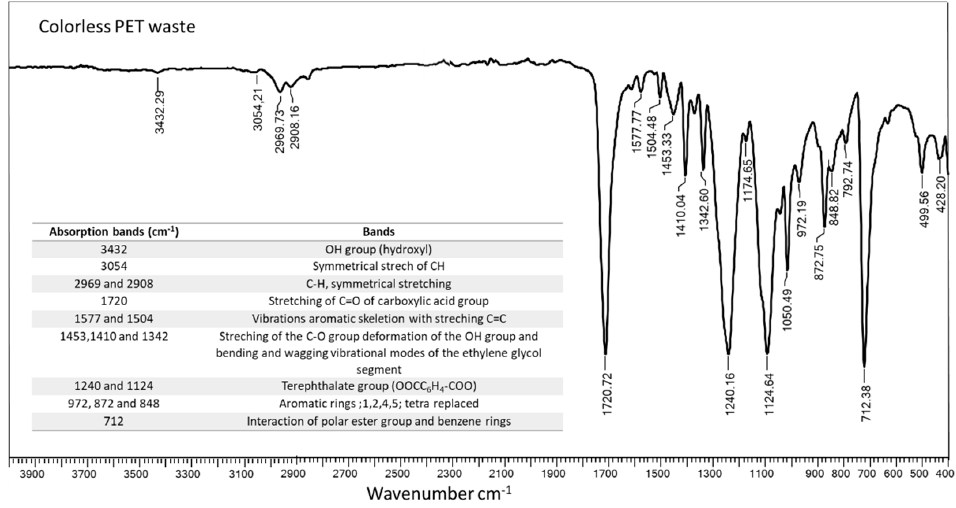
Figure 3. FTIR spectra of colorless PET waste before SubCW treatment.